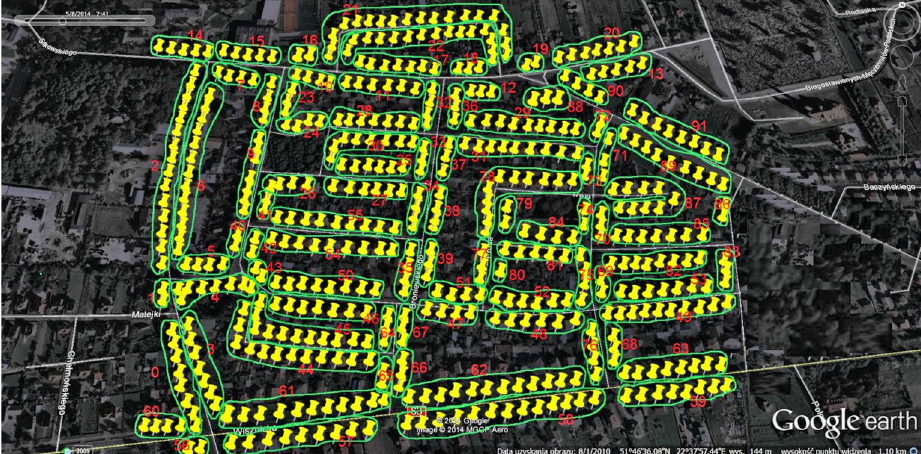
Fig. 2. Aggregated collecting points (source: created by the authors; Google Earth software was used)